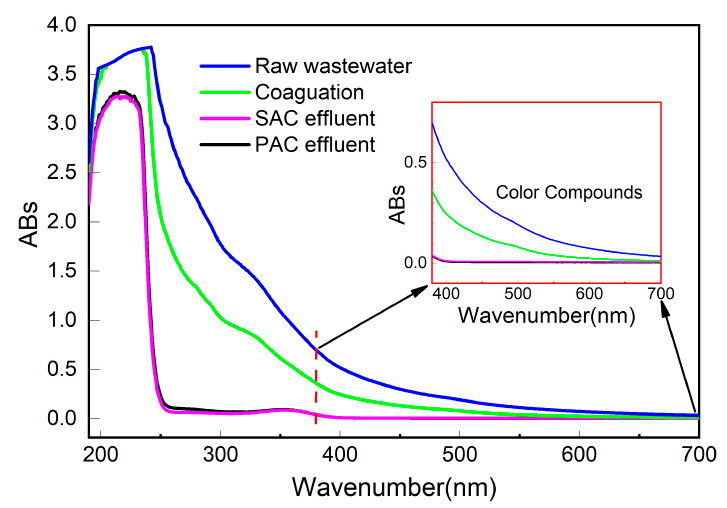
Figure 7. UV-vis absorbance spectra of BTCW and effluents of coagulation and SAC and PAC treat- ments.